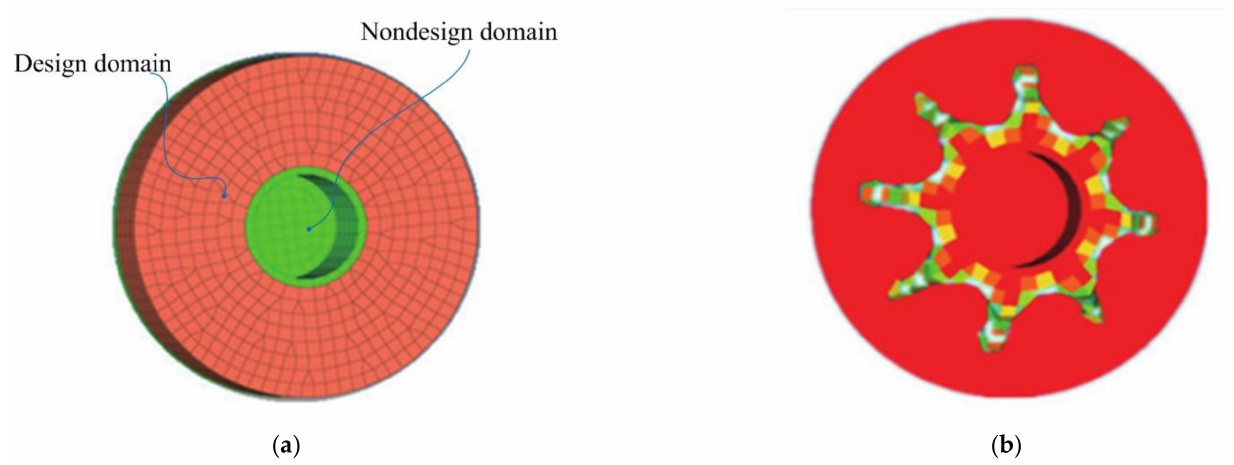
Figure 2. ( a ) Initial ground structure of mirror. ( b ) The result of topology